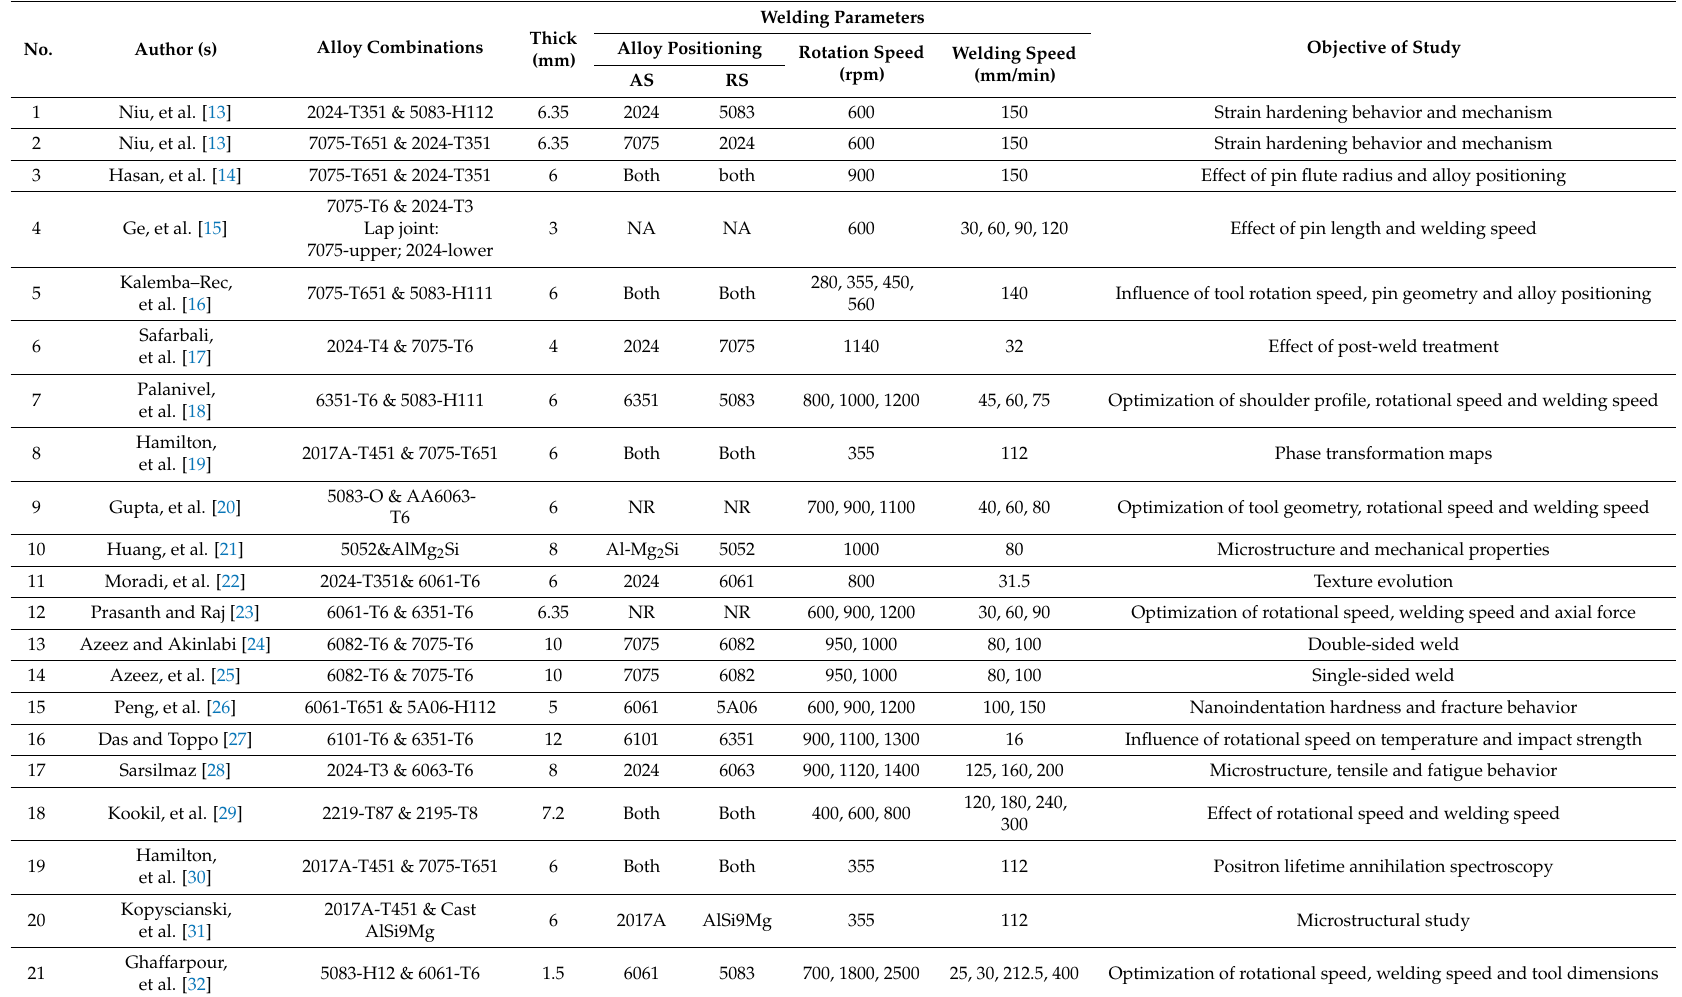
Table 1. Summary of FSW of dissimilar Al alloy joints studied in